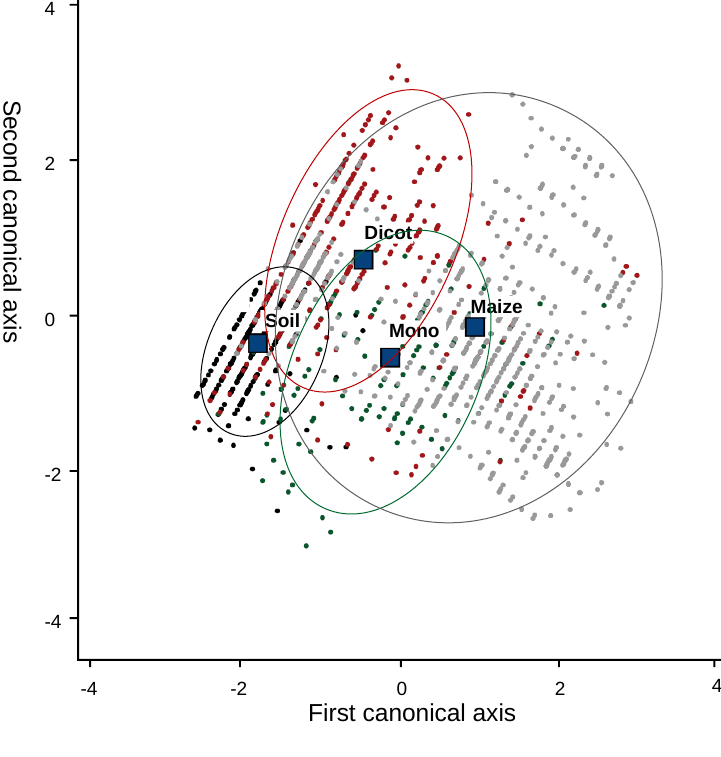
Figure 4. Canonical discriminant function plot of LIDAR measurements representing four groups: monocots, dicots, crop and soil.